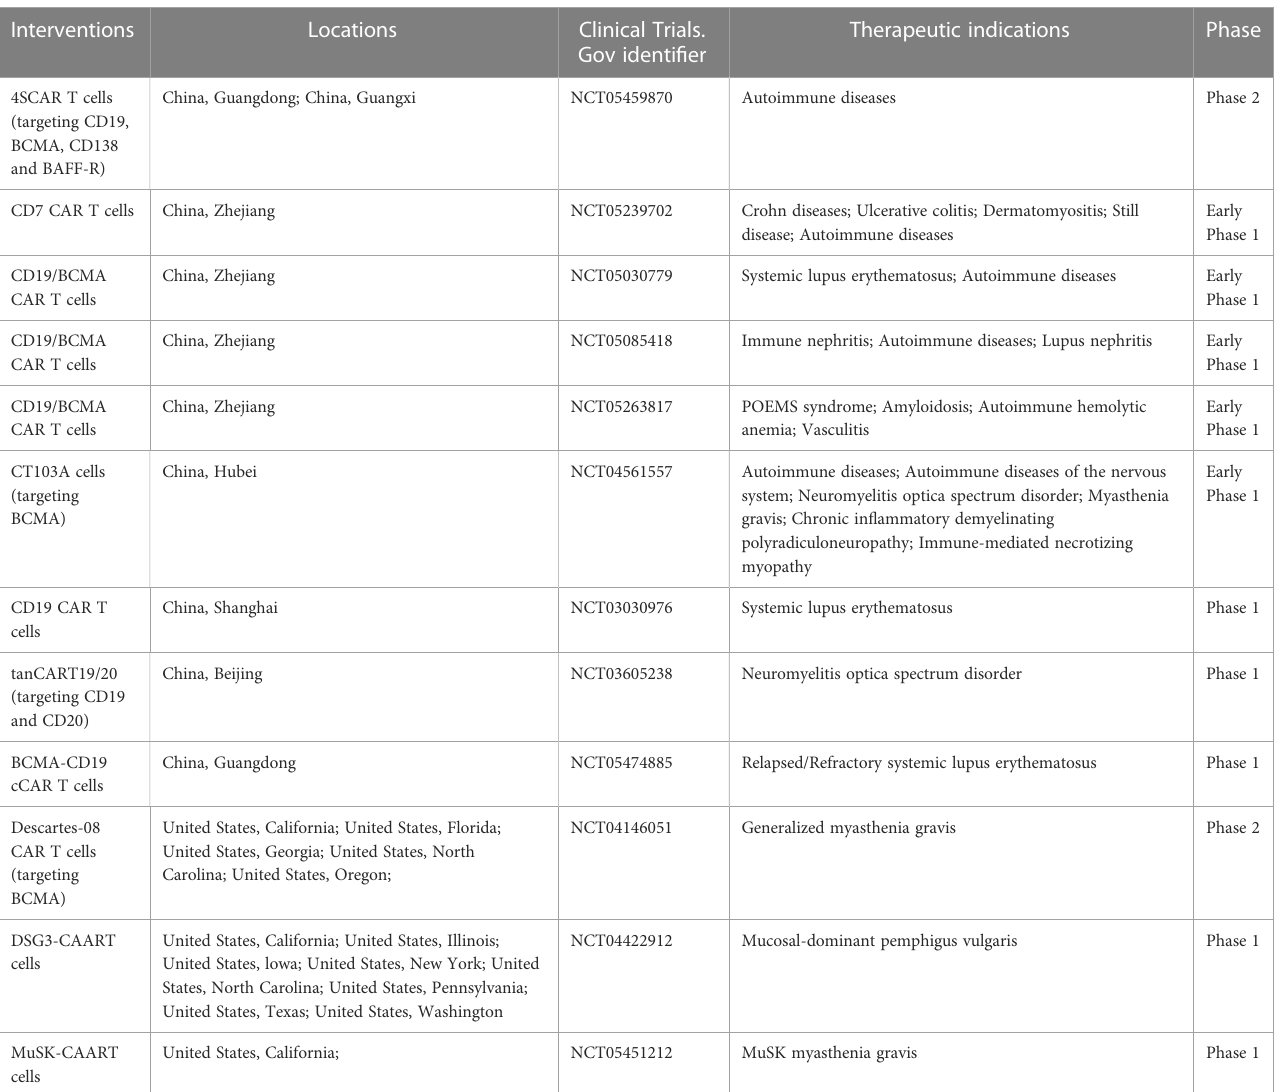
TABLE 2 Currently employed CAR-based therapies in autoimmune diseases. Interventions